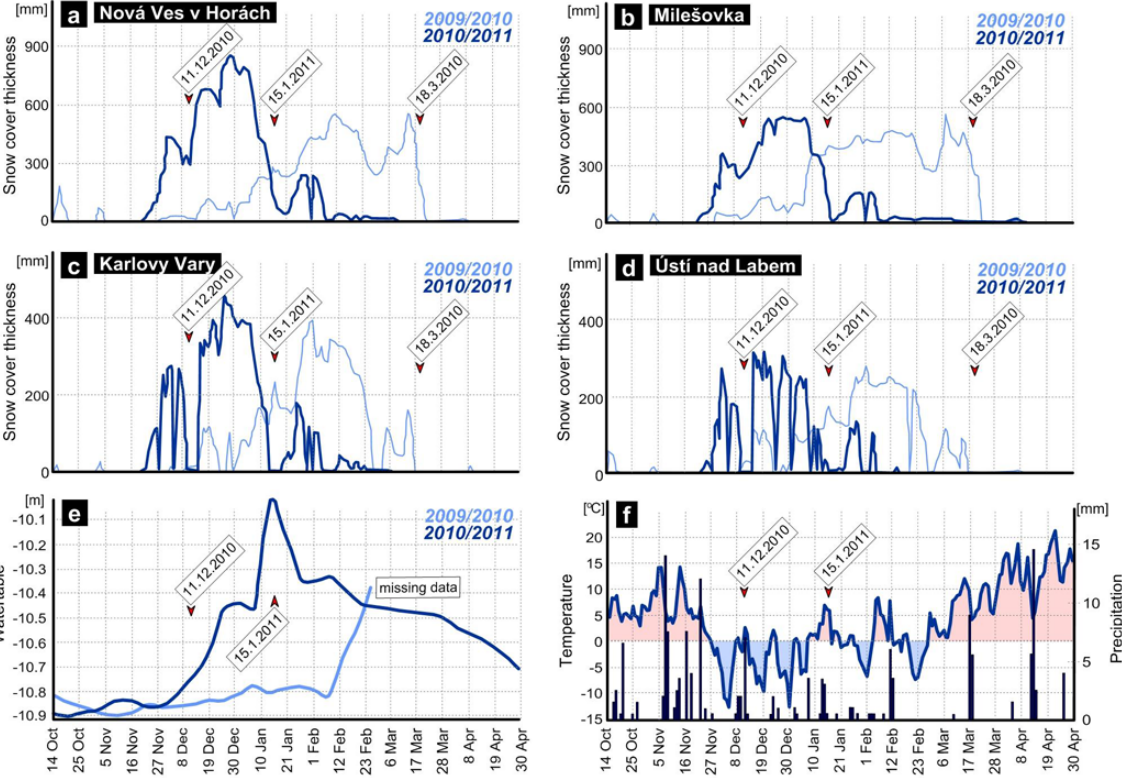
Fig. 9. The main triggering factors of the landslide reactivation (15 January 2011) were rapid melting of snow cover in the beginning of December 2010 and January 2011 (a–d) and a sudden increase in the water table in OW 212 (e) . These factors resulted from the increase in average temperature (Jezeˇr´ı meteostation) during January (f) (Data sources: Czech Hydrometeorological Institute; the meteostation Jezeˇr´ı operated by BCRI; Ch´an et al.,